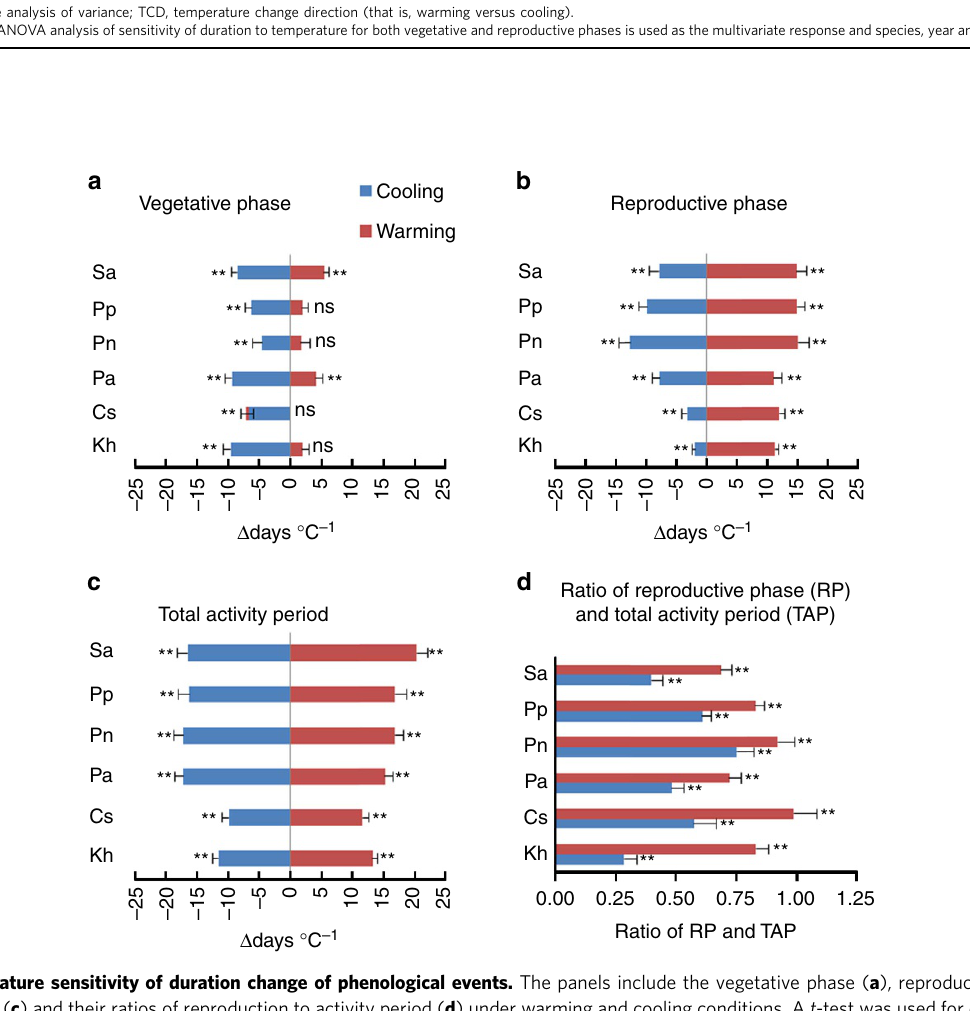
ANOVA, analysis of variance; TCD, temperature change direction (that is, warming and cooling). Repeated-measures ANOVA is used to test the effects of year, species and temperature change direction on sensitivity of duration change to temperature for the total aboveground activity period.